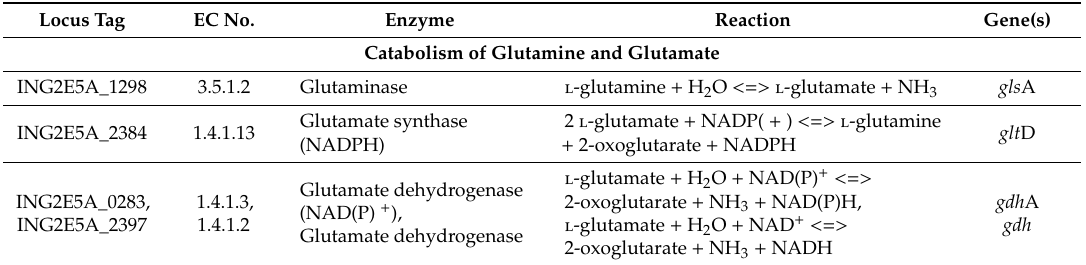
Table 2. Catabolism of amino acids and formation of acetate and propionate in P. mucosa ING2-E5A T . Locus Tag EC No. Enzyme Reaction Gene(s) Catabolism of Glutamine and